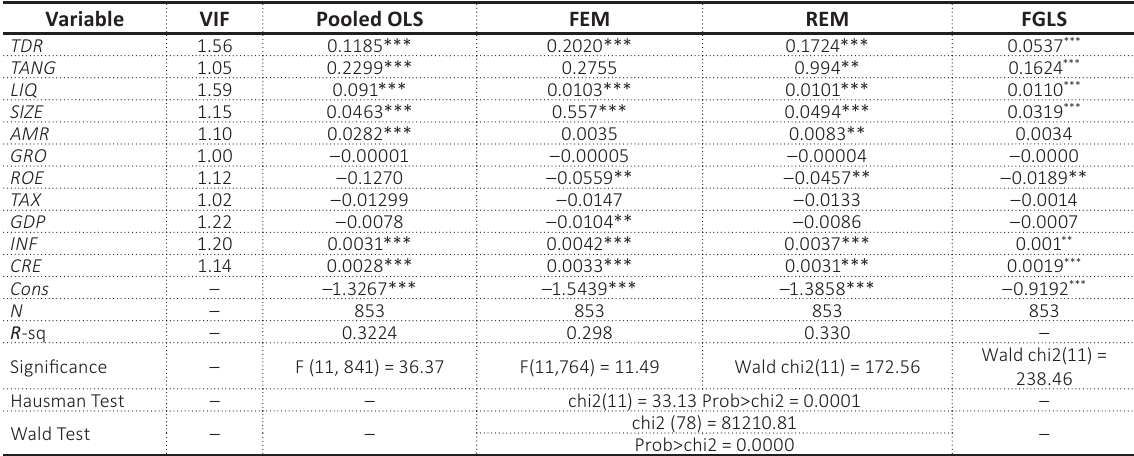
Table 3. Regression results using Pooled OLS, REM, FEM, and